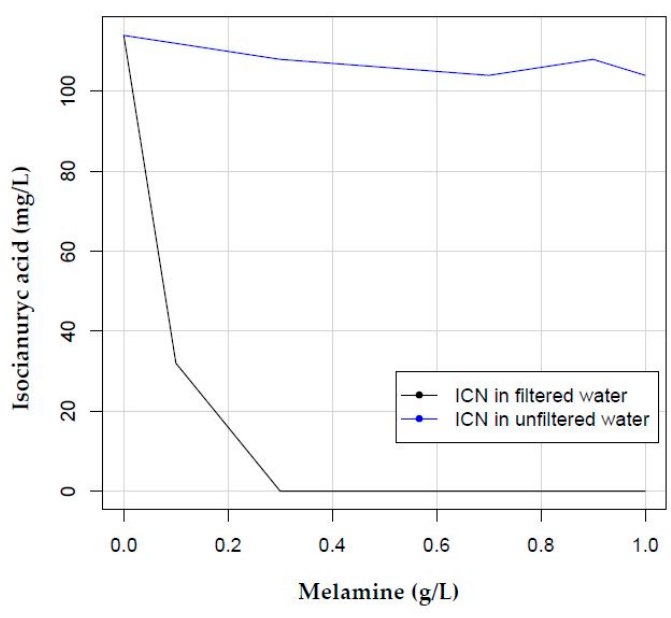
Figure 4. Variation of isocyanuric acid residual in the filtered water vs. adding melamine (0–1 g/L).